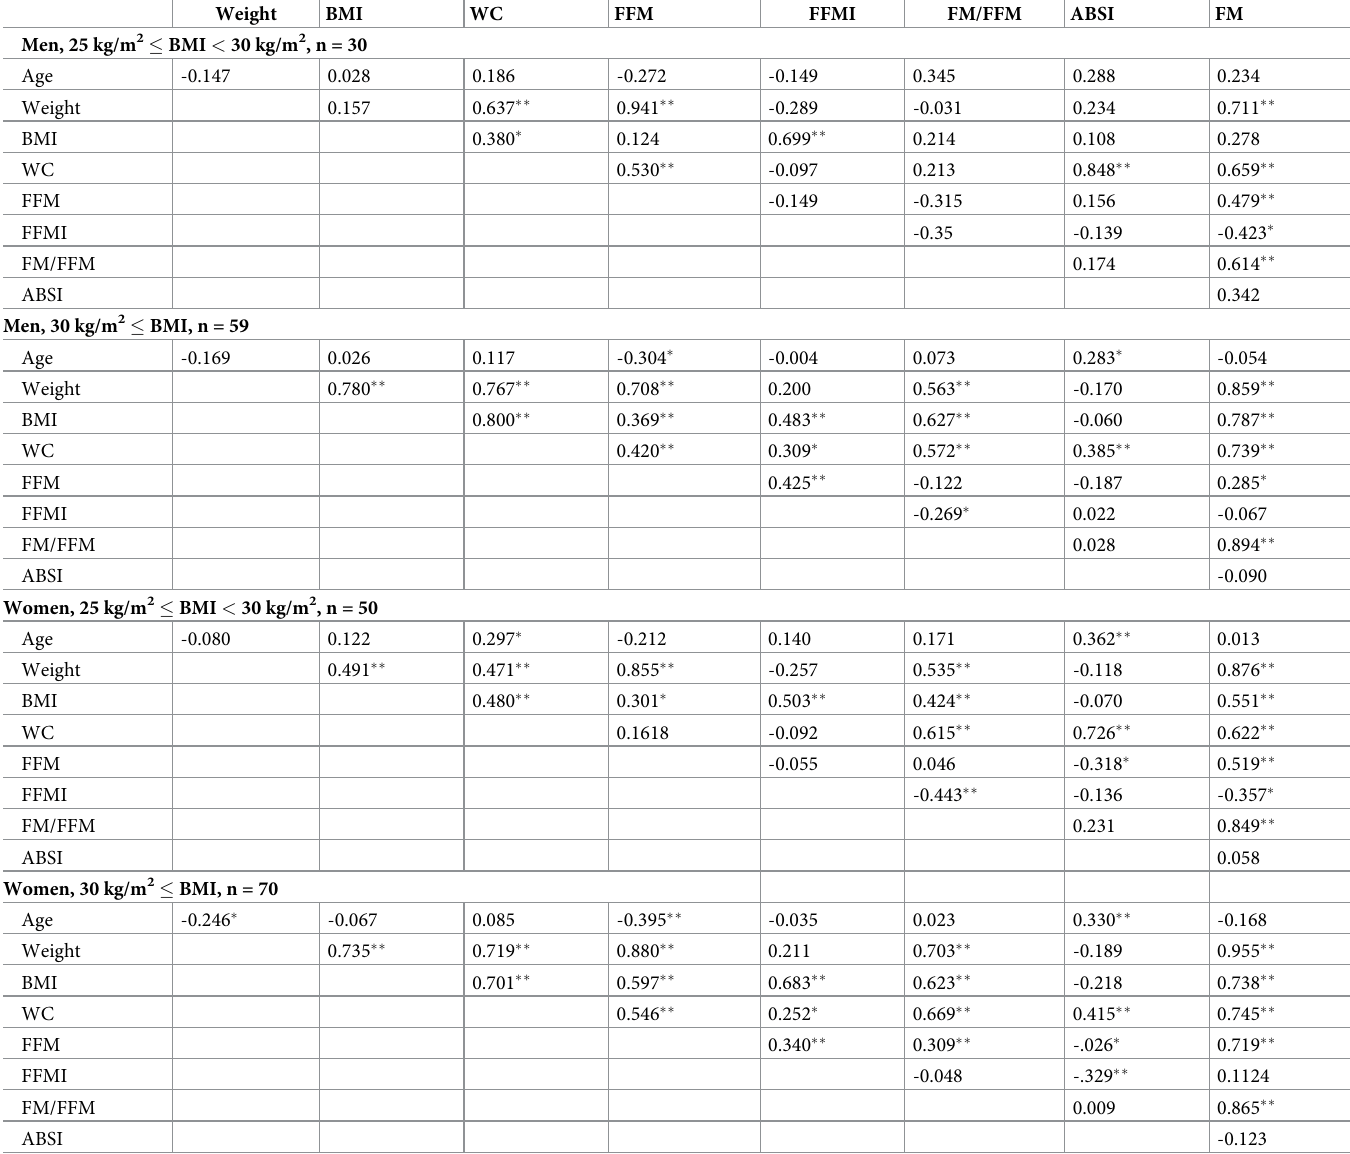
Table 4. Relationships between anthropometric and body composition parameters according to BMI and gender.